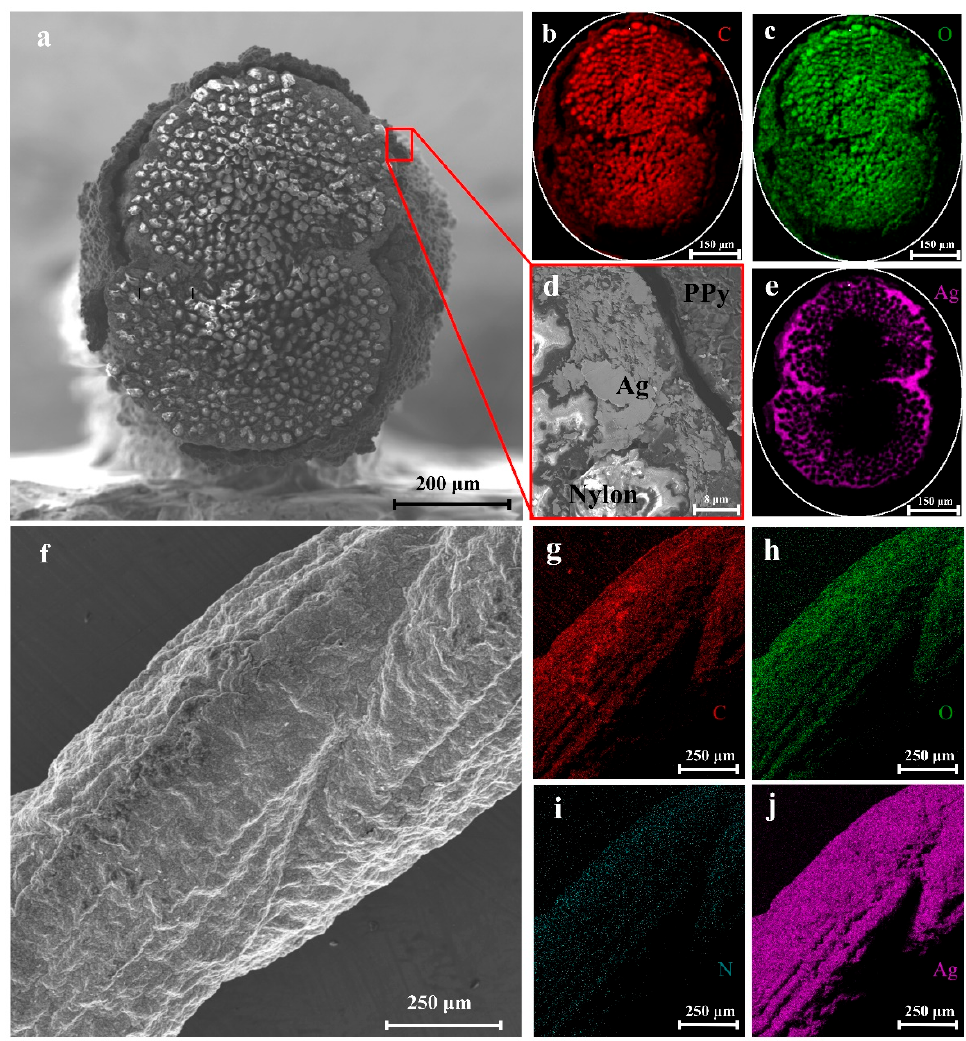
Figure 5. ( a ) Cross-sectional SEM image of the nylon/Ag/PPy electrode; ( b ) carbon and ( c ) oxygen element distribution in the cross-section; ( d ) di ff erent material layers of the cross-section of the ny- lon/Ag/PPy electrode; ( e ) silver element distribution in the cross-section; ( f ) lateral SEM image of the nylon/Ag/PPy electrode; lateral ( g ) carbon ( h ), oxygen ( i ), nitrogen and ( j ) silver element distri- bution.